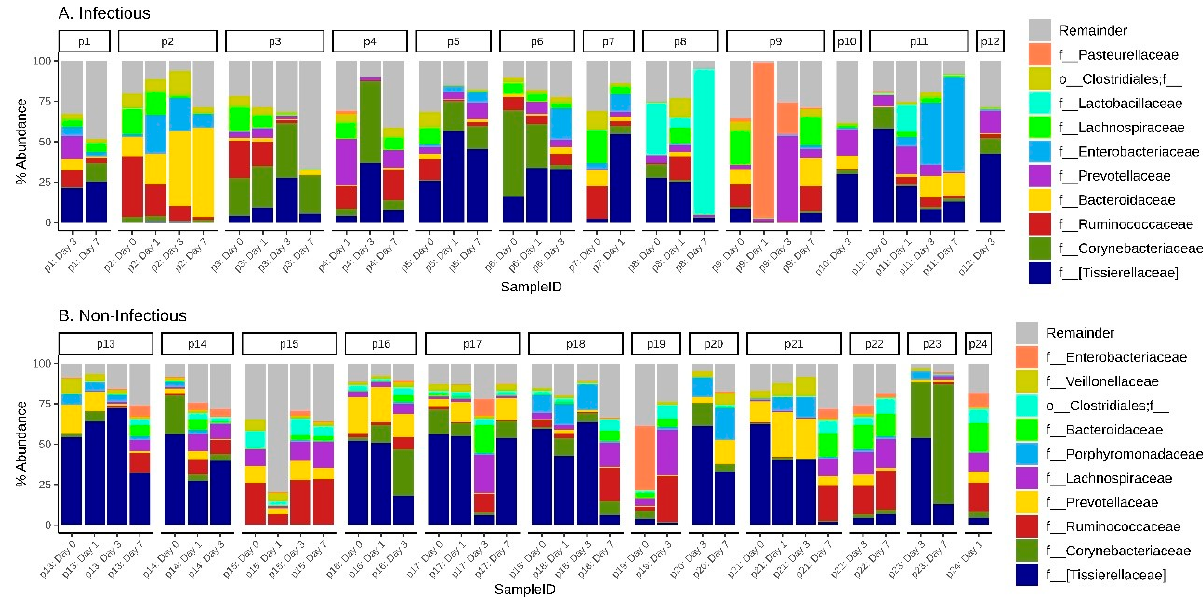
Figure 8. The top 10 families of the gut microbiota composition in both ( A ) infectious and ( B ) non-infectious groups of patients with temporal dynamics.